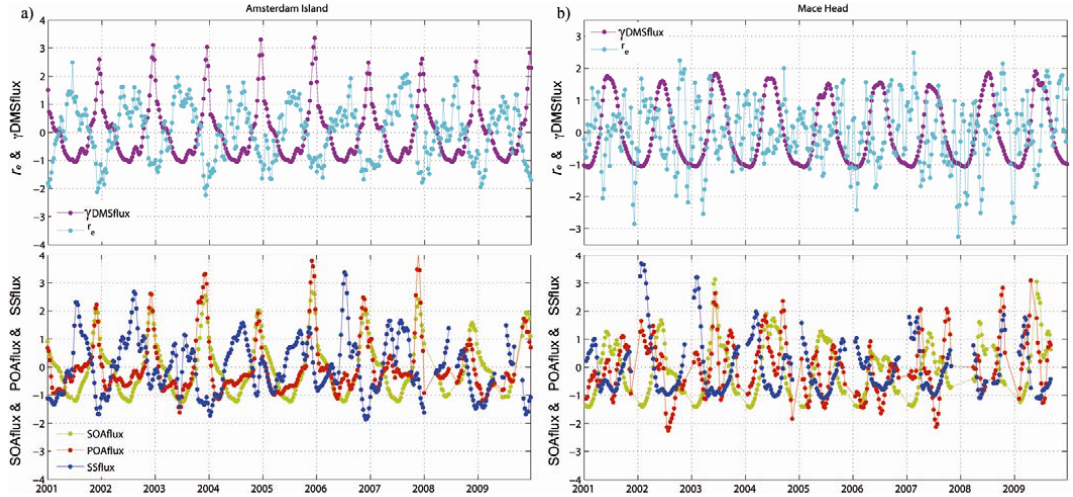
Fig. 3. Same as Fig. 2 but for the 7 ◦ × 7 ◦ regions upwind of (a) Amsterdam Island, and (b) Mace